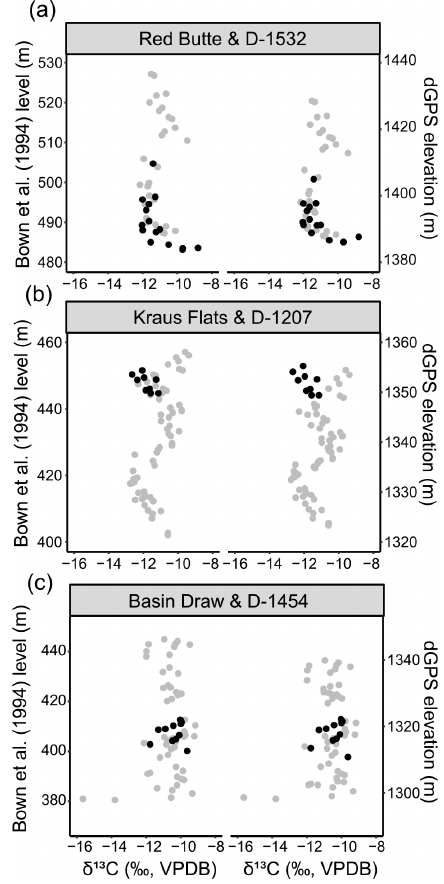
Figure B1. Carbon isotope stratigraphy through the (a) D-1532 (485 BCM level), (b) D-1207 (448 BCM level), and (c) D-1454 (409 BCM level) fossil localities (black) along with the nearest main section (grey). Points represent average δ 13 C from a stratigraphic level. All data are shown according to their Bown et al. (1994) equivalent meter level (left) and differential GPS elevation